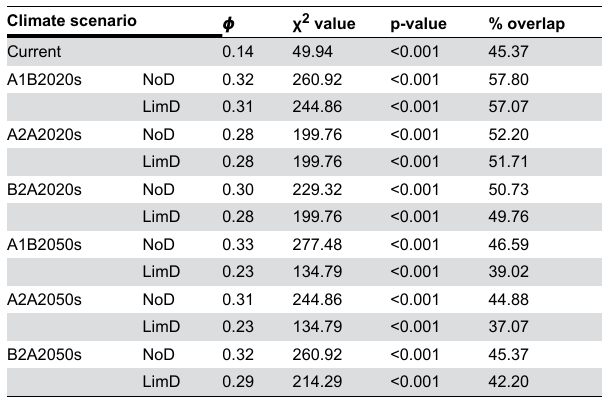
Table 2. Strength of association (coefficient of correlation ϕ ) and percent overlap between hot-spots of irreplaceability and Natura 2000 planning units under current and future climate conditions (2020s and 2050, three emission scenarios) under limited dispersal (LimD) and no dispersal (NoD)